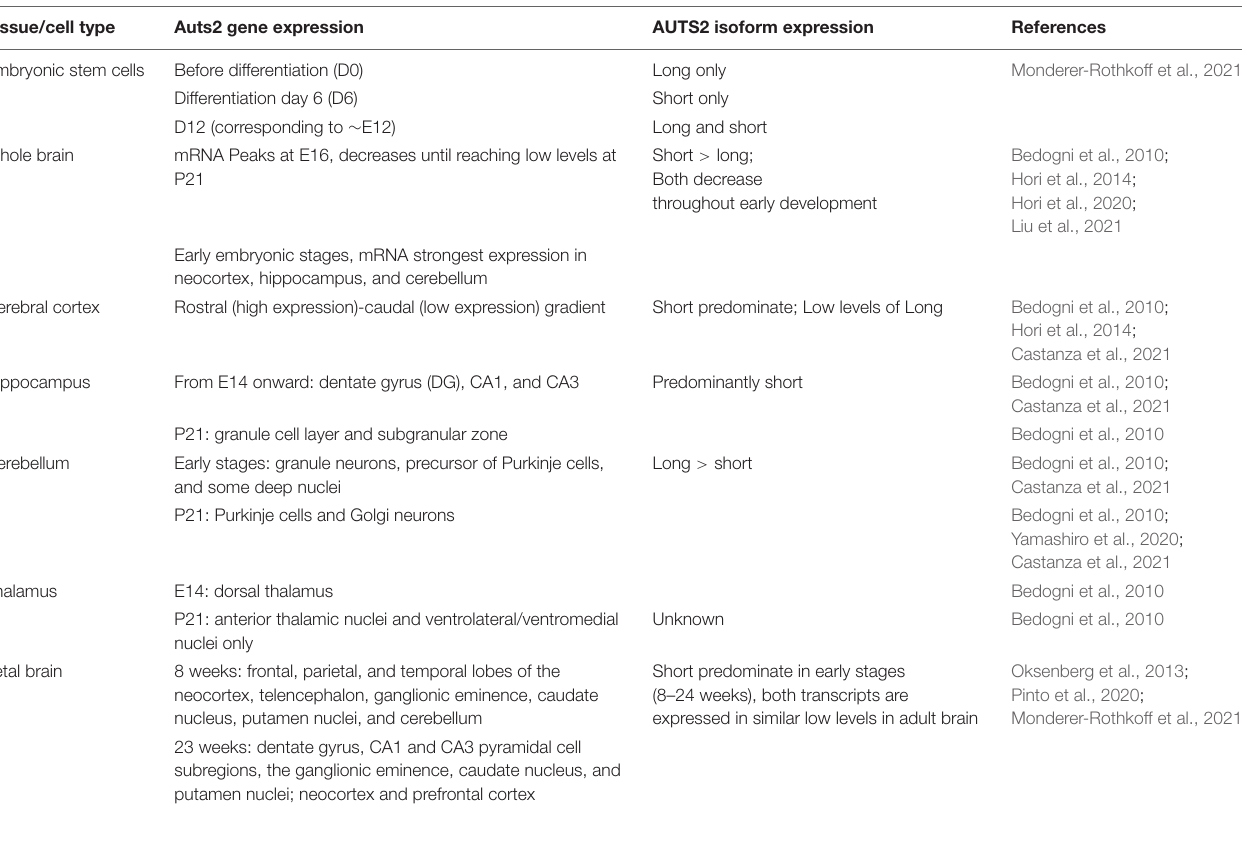
TABLE 1 | AUTS2 expression in developing brain and cultured